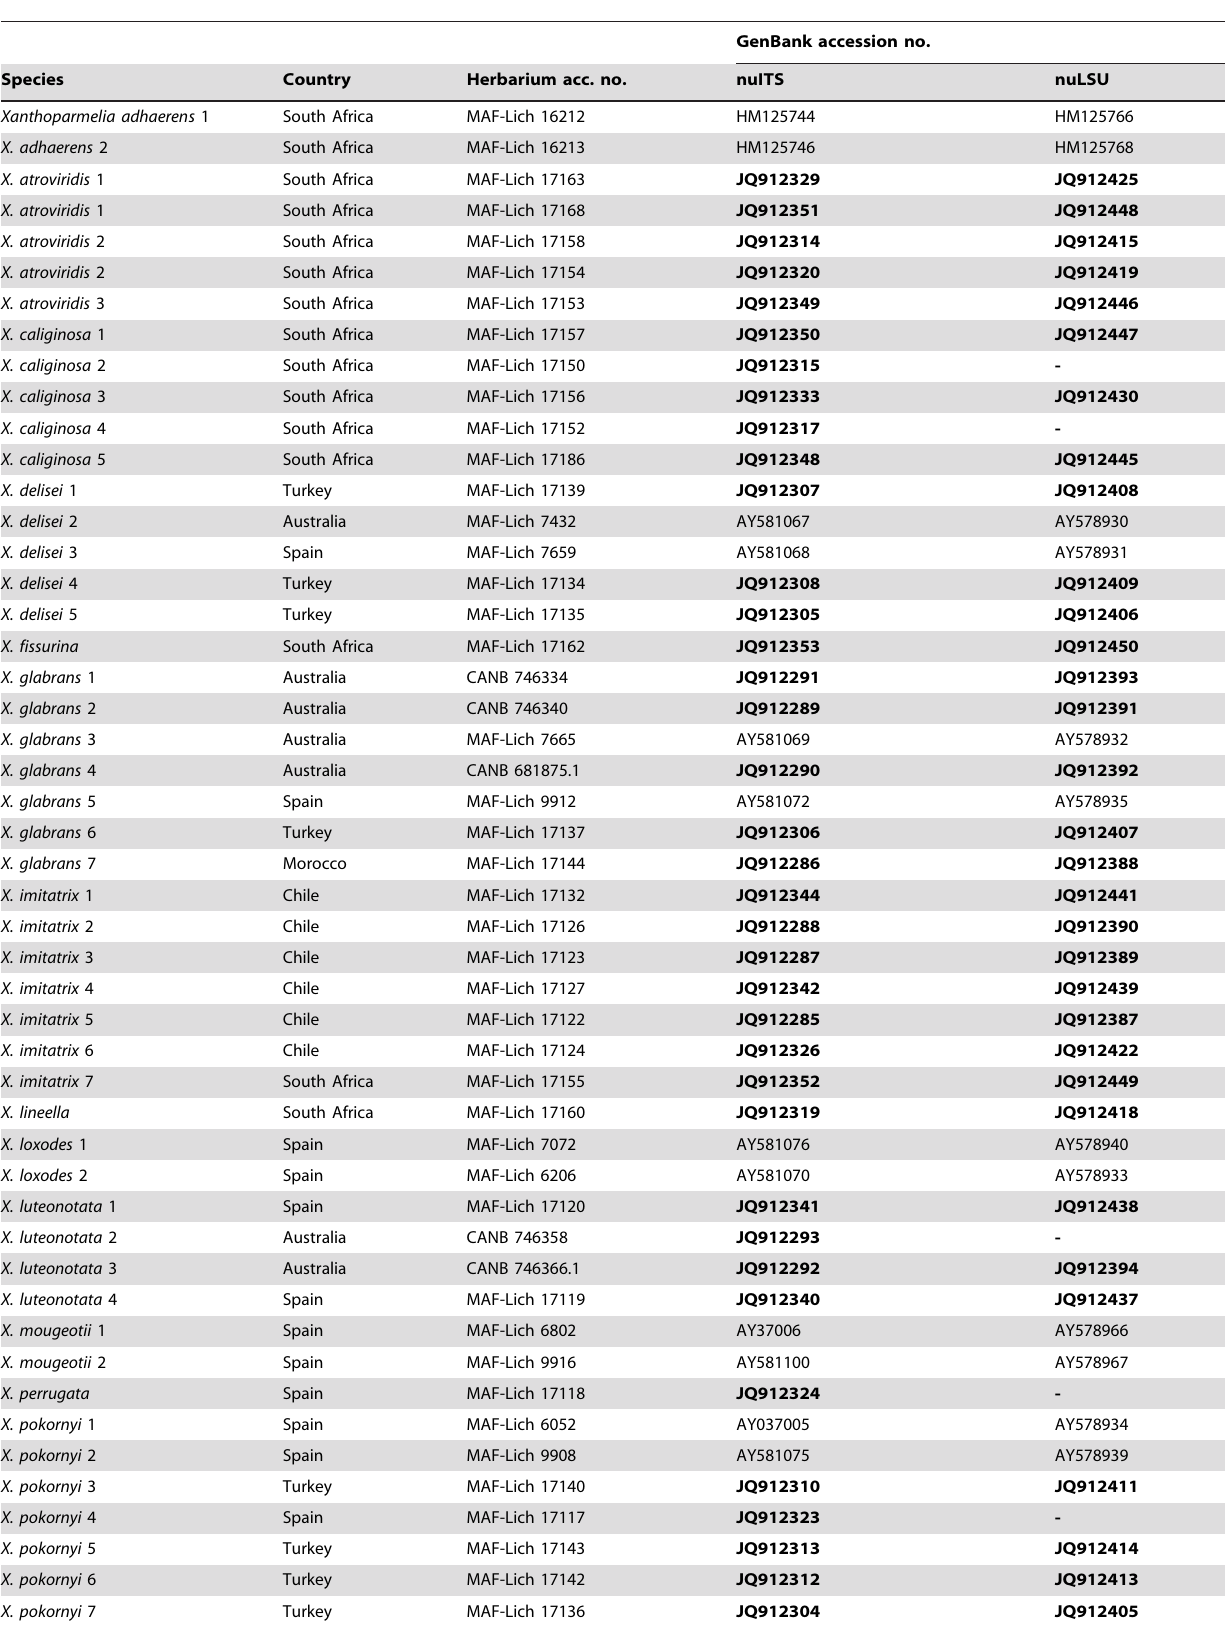
Table 2. Specimens used in this study with country of collection, voucher information and GenBank accession numbers.